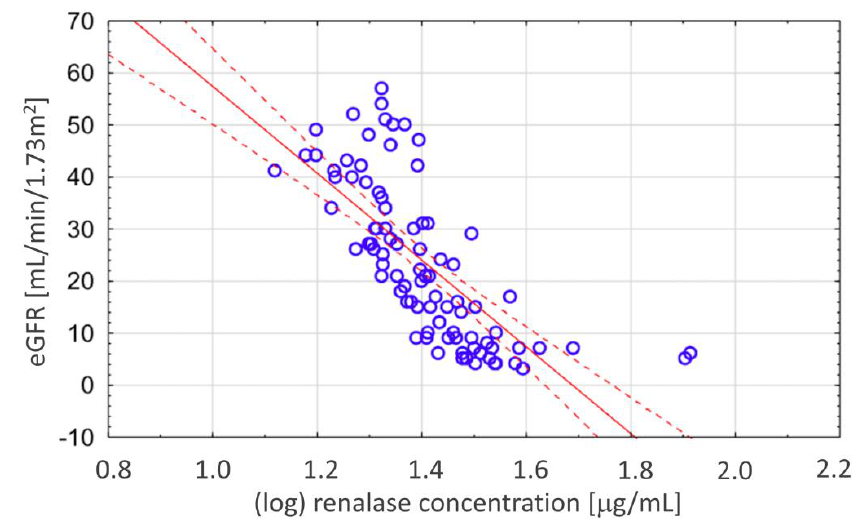
Figure 2. The negative, strong correlation between renalase and eGFR in the CKD group.